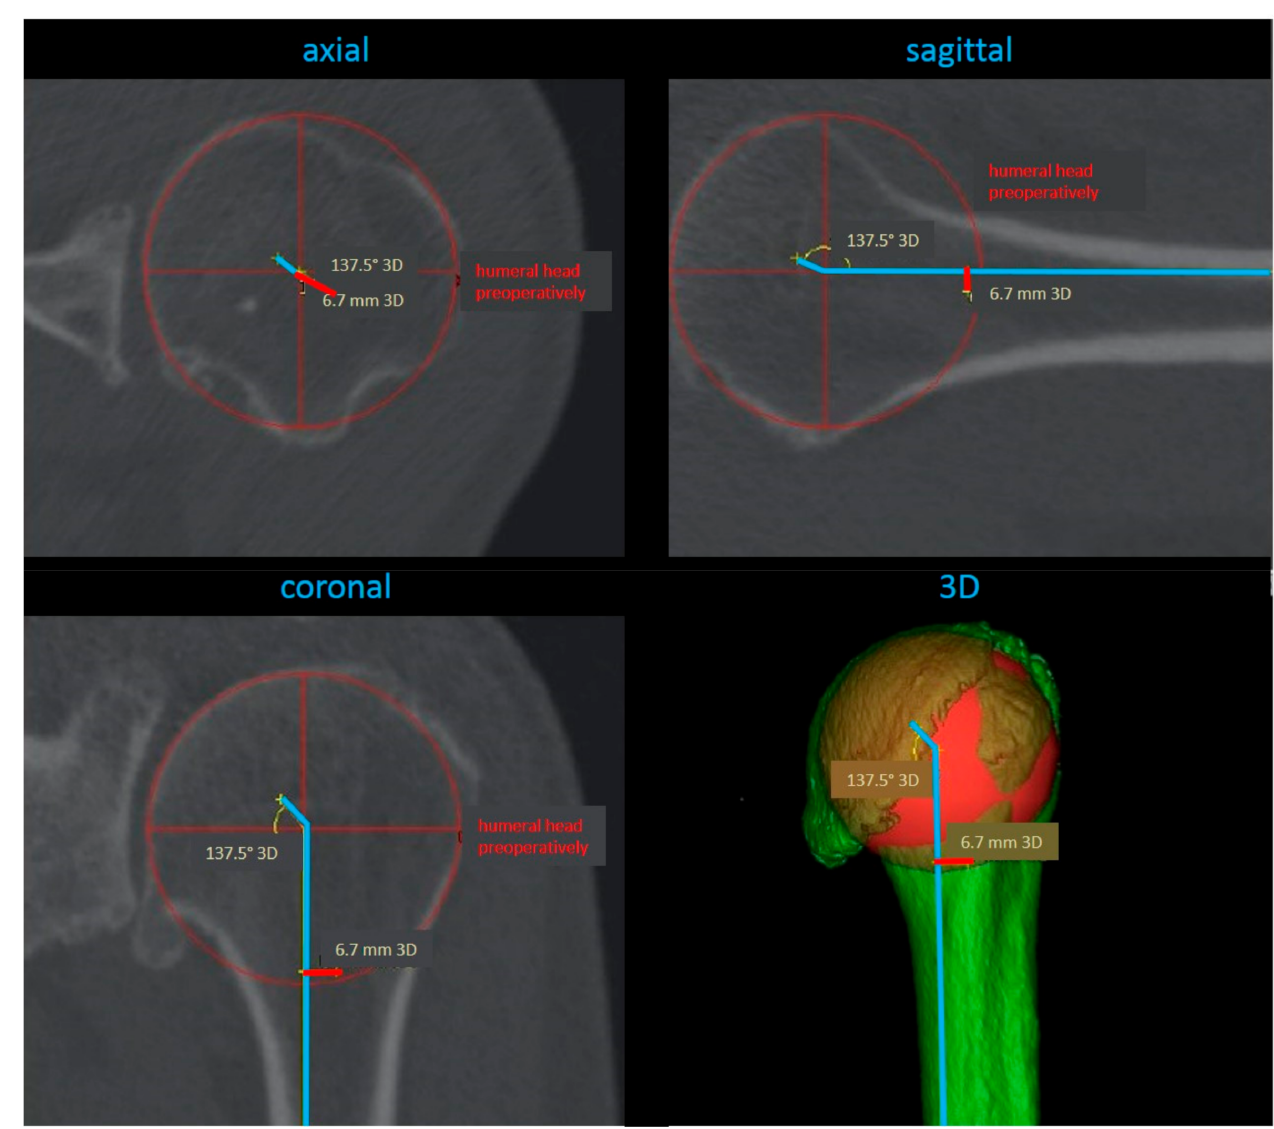
Figure 4. Calculation of the geometrical parameters in sagittal, axial, and coronal planes, respectively, and a 3D